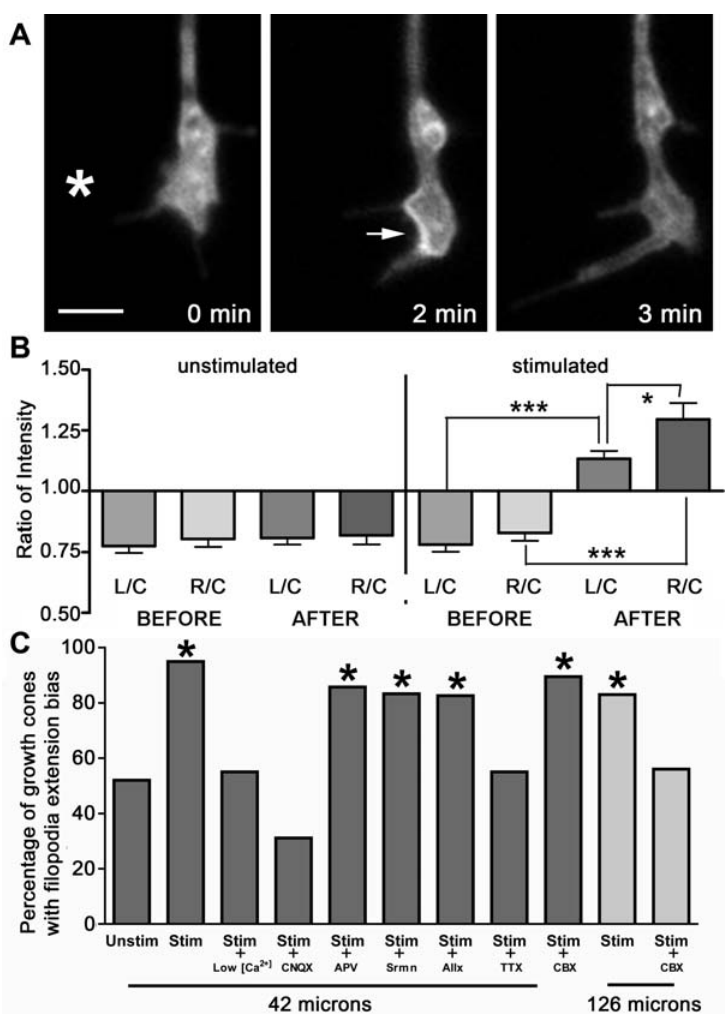
Figure 3. A role for VAMP-2, calcium, non-NMDA receptors and gap junctions in activity-induced attractive filopodia extension. (a) 2 minutes after stimulation GFP-VAMP-2 clusters near the membrane, mostly on the right side. (b) The mean grey value (intensity) of a region of interest was measured from the left side (L), right side (R) and cytoplasm (C) of growth cones from GFP-VAMP-2 neurons before and after stimulation. The intensity ratios L/C and R/C increase after a stimulation (n=20; p , 0.0001, two-sided unpaired student’s t-test). R/C is also significantly higher then L/C after stimulation (p=0.0344). The intensity ratios (L/C and R/C) do not change when cells are monitored for the same amount of time without a voltage pulse (n=21, p . 0.05). Error bars represent standard deviations. (c) The attractive filopodia extension is calcium dependent and is blocked by CNQX. The effect is blocked by CBX when depolarization is performed at 126 m m but not 42 m m. Control, n=25; stimulated (42 m m), n=20; low Ca 2 + (42 m m), n=20; 10 m M CNQX(42 m m), n=22, 50 m M APV(42 m m), n=21; 100 m M suramin (Srmn) (42 m m), n=18; 4 m M